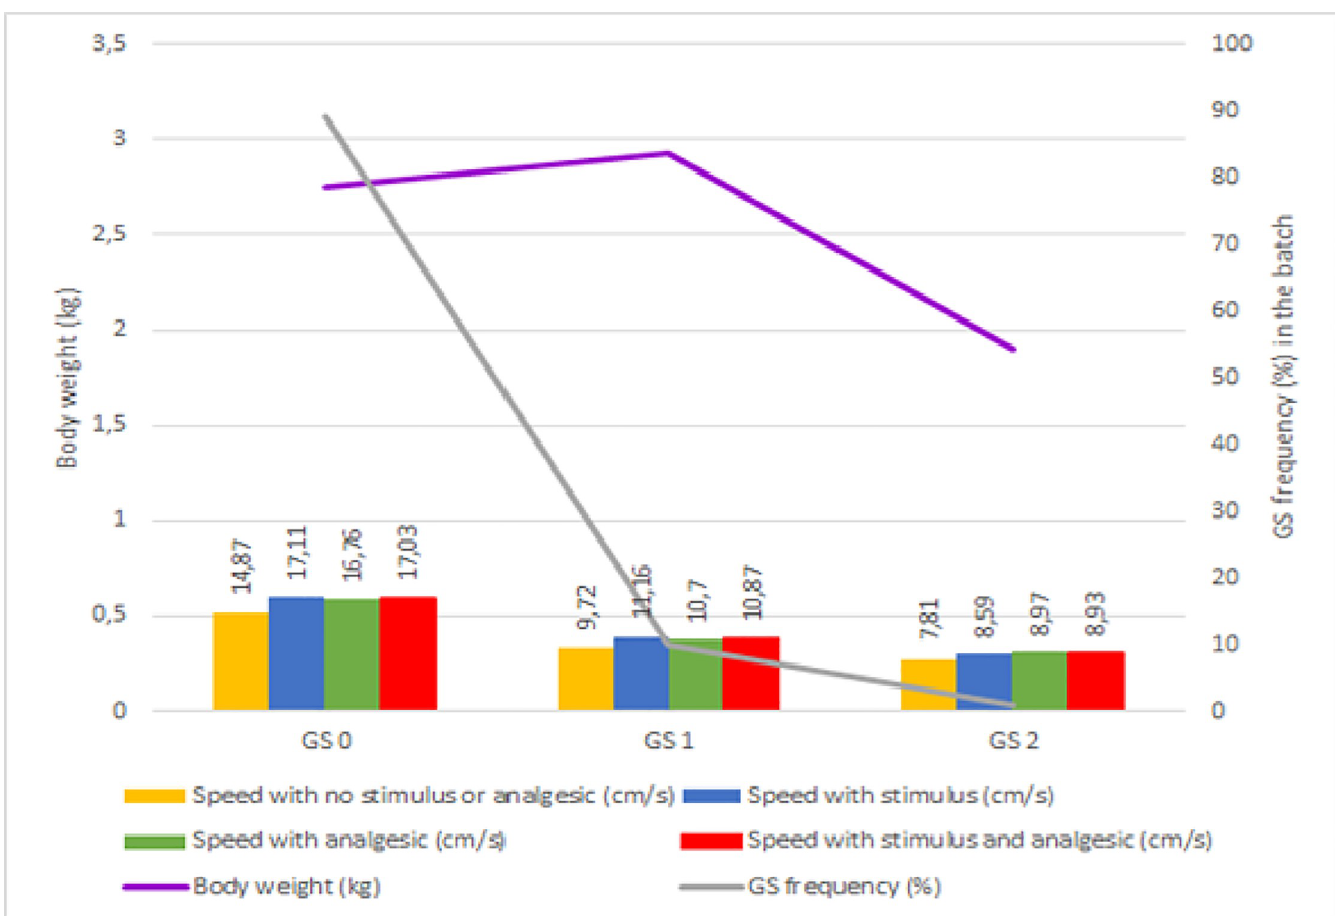
Fig 2. Frequency of gait score, speed of broilers chickens at 41 days of age, body weight at 40 days of age of broilers with or without stimulus, and with or without application of analgesic. Score 0 (GS 0): Healthy birds that exhibited no abnormality when walking; Score 1 (GS 1): Birds that exhibited difficulty to walk that impacted their locomotion ability in a way that was easily identifiable through observation; Score 2 (GS 2): Birds that exhibited severe issues and walked only when highly motivated.